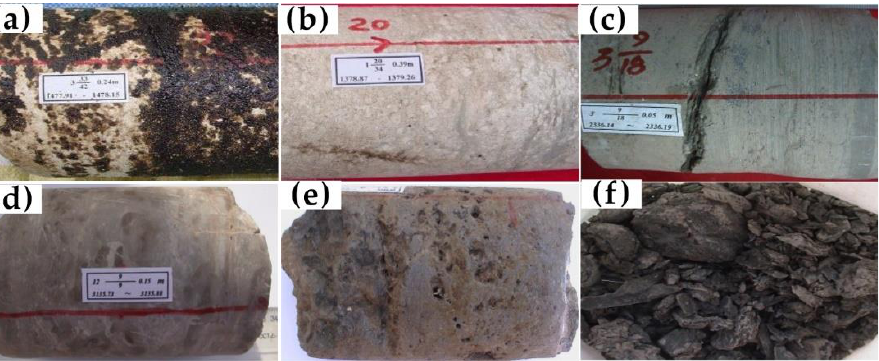
Figure 4. Reservoir core photo of North Truva oilfield ( a ) Grainstone. Well CT-52, 1477.92 m, with oil stains on the surface, clean rock particles by elutriation, strong hydrodynamic force, a small total amount but many types of pores, and one fracture; ( b ) Packstone. Well CT-52, 1379.22 m, the marl is mostly oil immersed and a little dolomitized, with few pore types and high content, and a high- angle fracture is discovered; ( c ) Wackestone. Well CT-22, 2336.18 m, the bioclastics are not evenly distributed, no pores are found, and a structural fracture is seen extending far, with a fracture width >5 mm, and it is not filled; ( d ) Siliceous limestone. Well CT-4, 3135.73 m, with strong chalcedony and mild dolomitization, no dissolved pores, very few pores, and six mesh fractures; ( e ) Granular dolomite. Well CT-4, 3135.73 m, with well-developed dissolved pores and large pore size, many dissolved trenches and dissolved fractures, and good connectivity. There are semi-filled gypsum and silt in the karst cave; ( f ) Mudstone. Well CT-4, 3134.21 m, gray-black mudstone, with irregular laminar structure, weak consolidation, local loss of plasticity, and no pores or